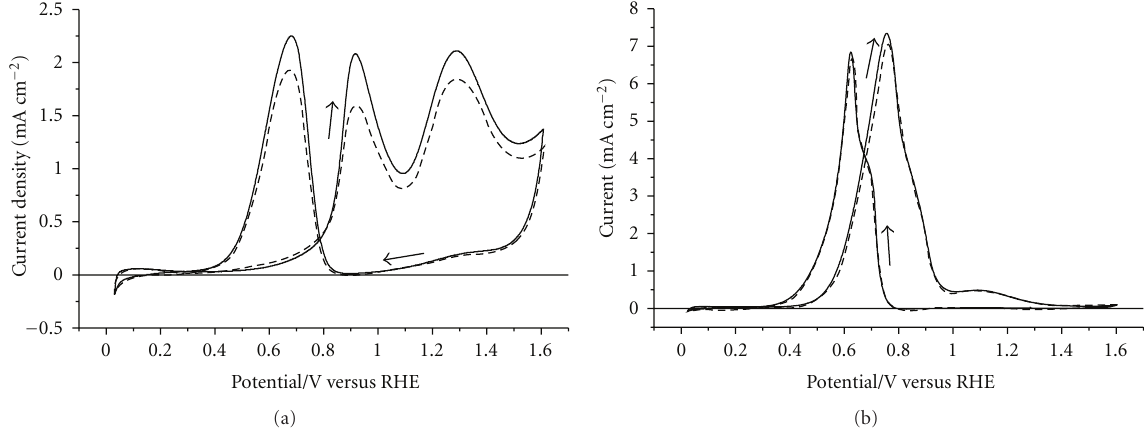
Figure 5: Cyclic voltammetry of ethanol solutions containing a mixture of ETBE and Bitrex in 0.5M H 2 SO 4 (a) and 0.1 M KOH (b). 1M ethanol (line) and 1M ethanol + 0.24wt.-% ETBE/0.5mgL − 1 Bitrex (dashed). Scan rate 50mVs − 1